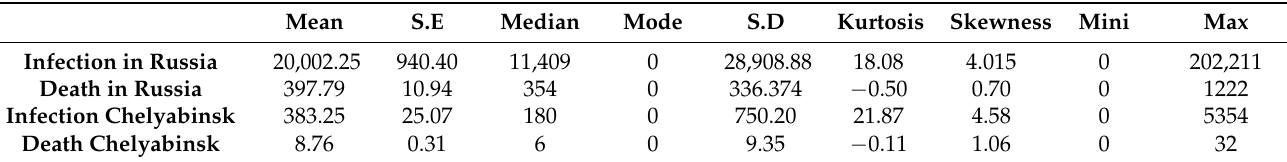
Table 2. Descriptive statistics of